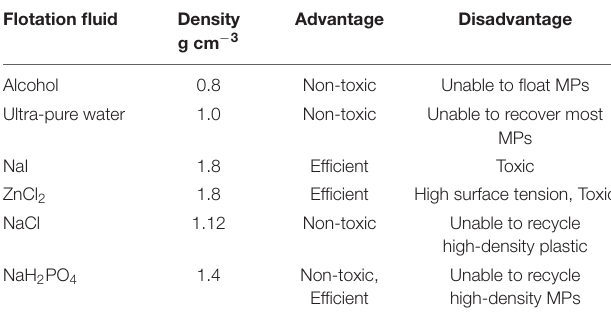
TABLE 1 | Density and advantages and disadvantages of flotation